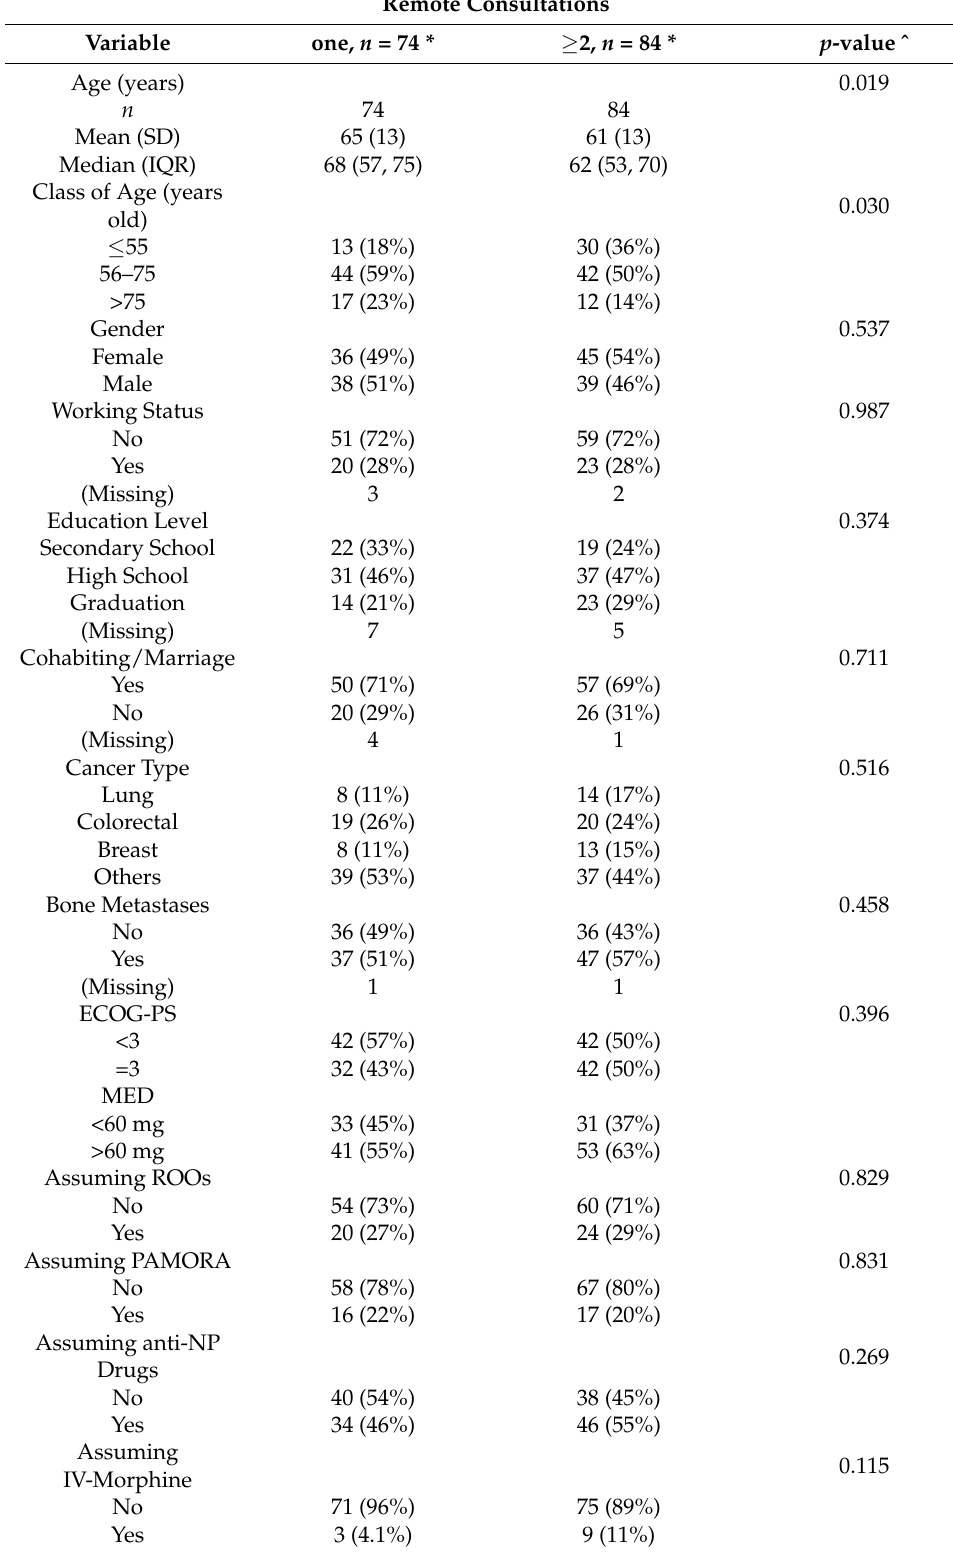
Table 3. Univariate analysis for data